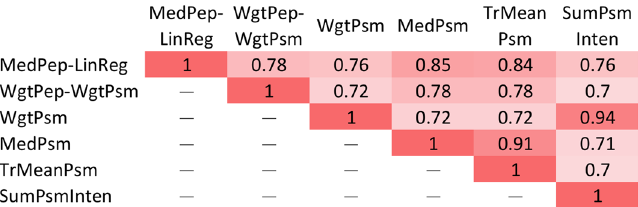
Figure 5. Pairwise similarities of (potential) temperature-dependent proteins between the 6 algorithmic combinations with RCC. Deep color indicates higher similarity. MedPep-LinReg stands for MedianPepRatio- LinearRegression; WgtPep-WgtPsm stands for WeightedPepRatio-WeightedPsmRatio; WgtPsm stands for WeightedPsmRatio; MedPsm stands for MedianPsmRatio; TrMeanPsm stands for TrimmedMeanPsmRatio; SumPsmInten stands for